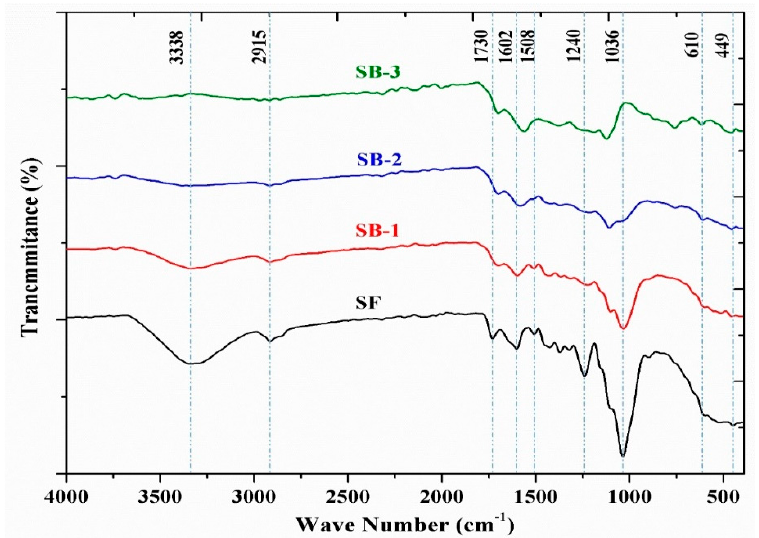
Figure 6. FTIR spectra of sesame stalk feedstock (SF) and its different biochar types: SB-1 (around the inner sidewalls of the internal chamber); SB-2 (formed on the upper part of the internal chamber); and SB-3 (conventional production).